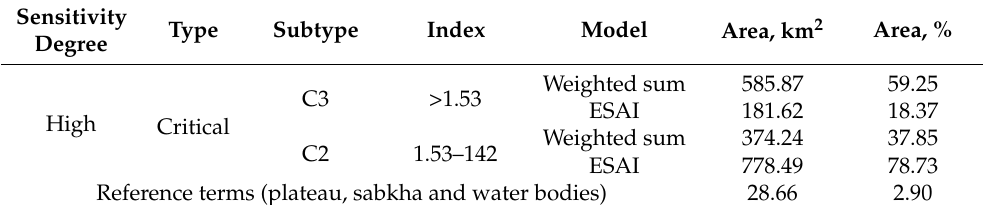
Table 8. Classes and areas of sensitive areas to desertification in the studied area.